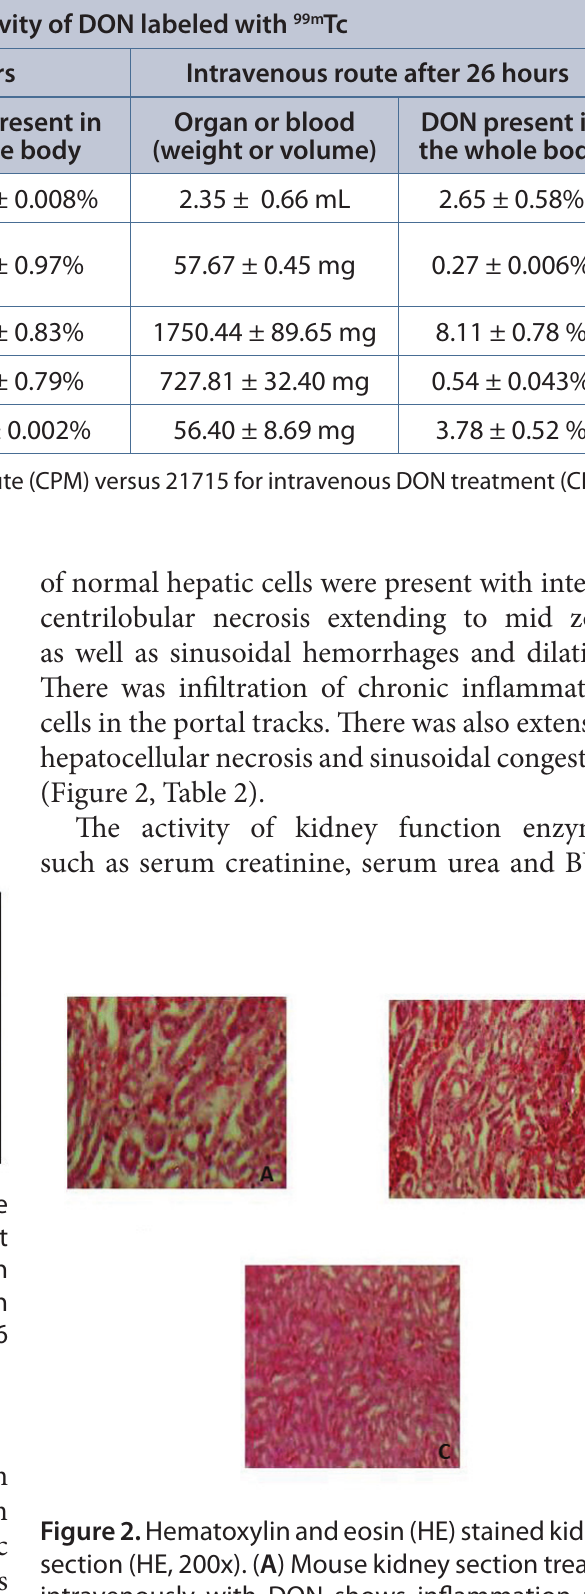
Radioactivity of DON labeled with 99m Tc